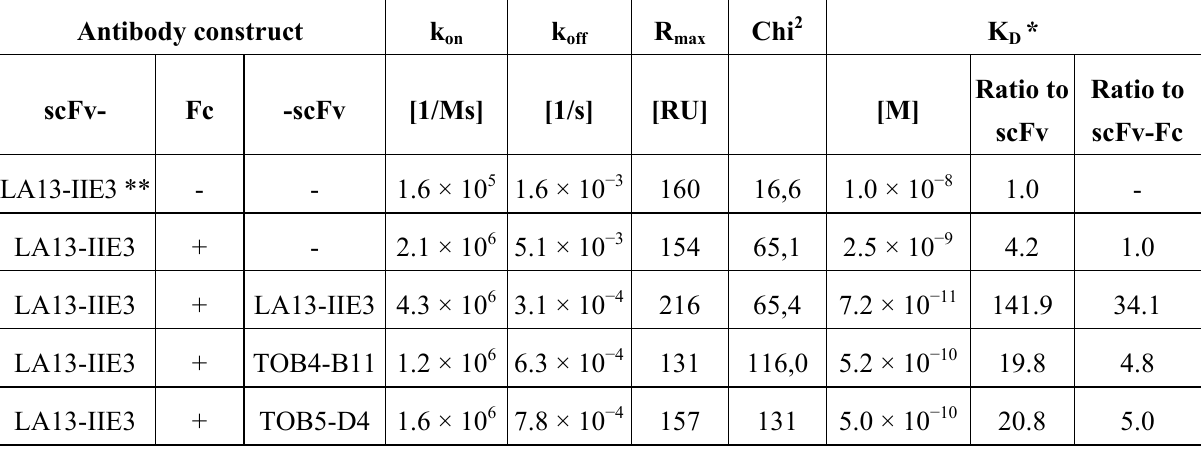
Table 3. Binding kinetics measured by SPR and analyzed using the 1:1 Langmuir model. Antibody construct